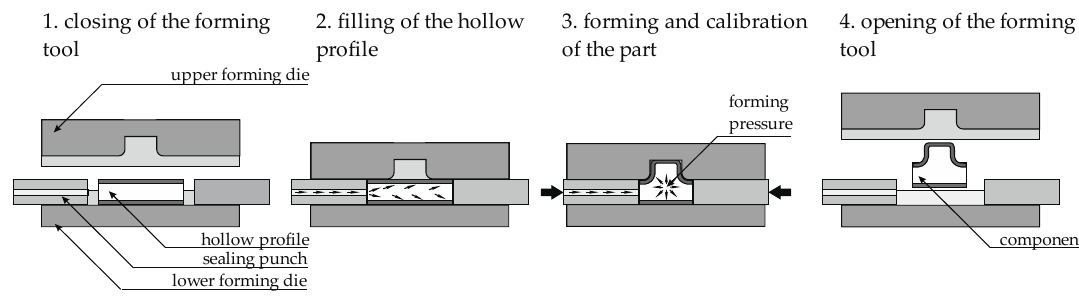
Figure 1. Schematic visualization of principle of hot tube gas forming.